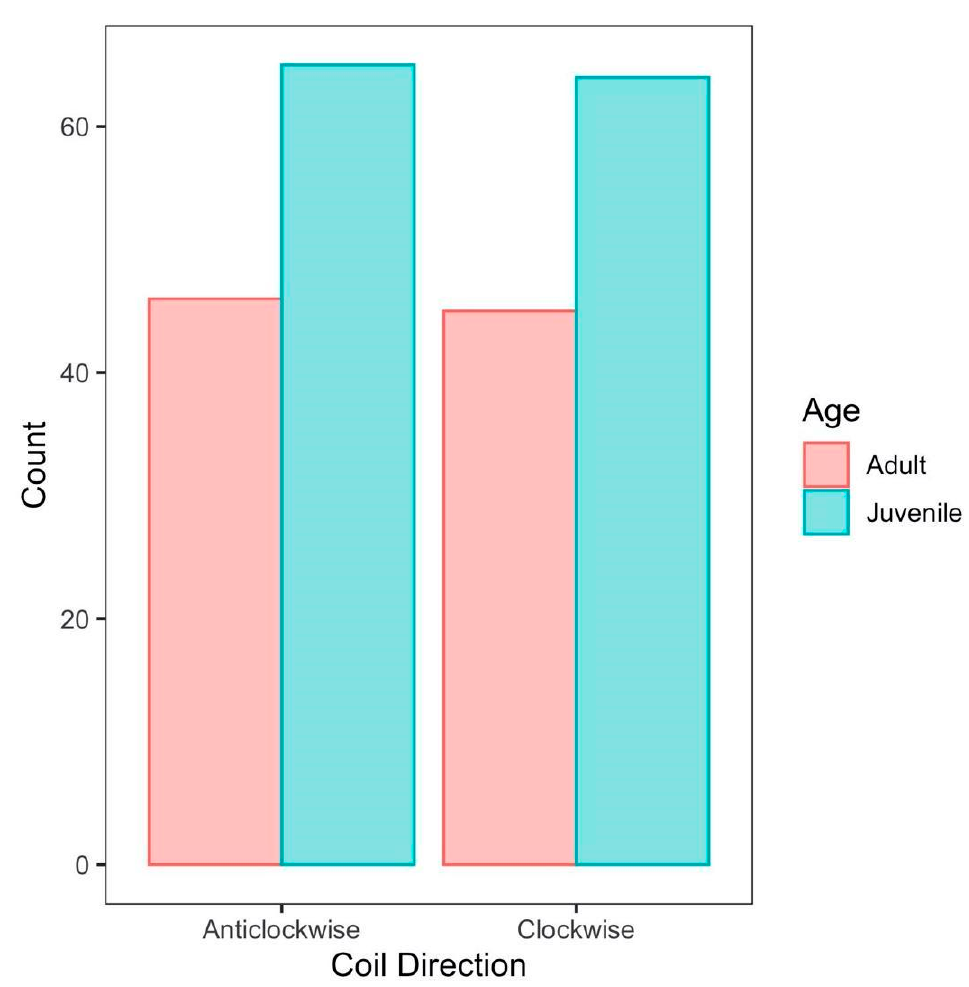
Figure 2. Age and Coil Direction. Snakes were divided by age groups (juvenile and adult) and coil directions were quantified as either clockwise or anticlockwise.